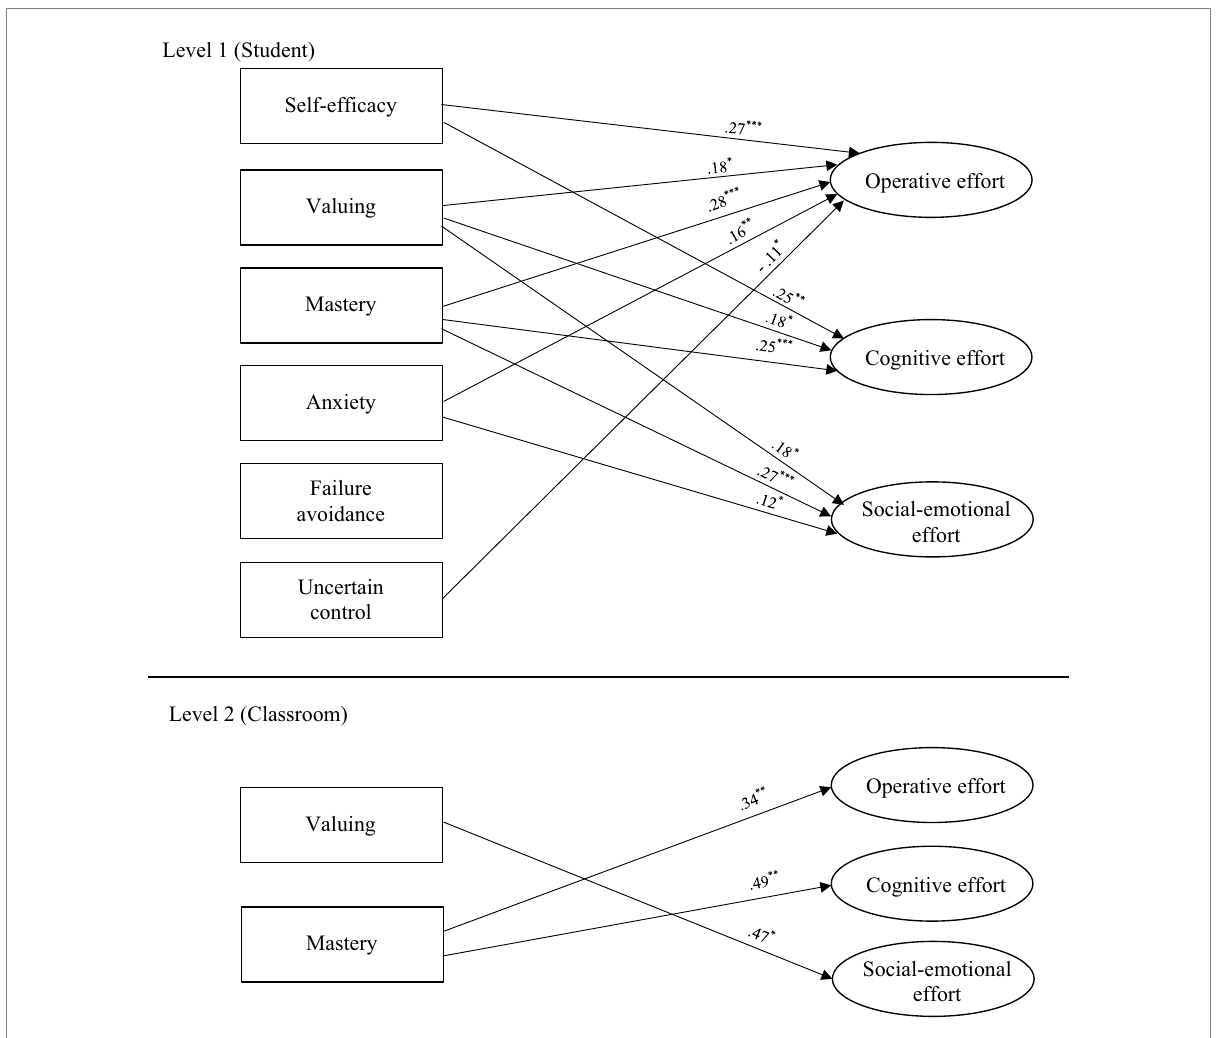
FIGURE 2 Significant substantive paths in central multilevel analysis—First order effort factors (MSEM 1 ). Only significant paths are shown and are labeled with standardized betas ( Table 3 for all covariate associations and all non-significant